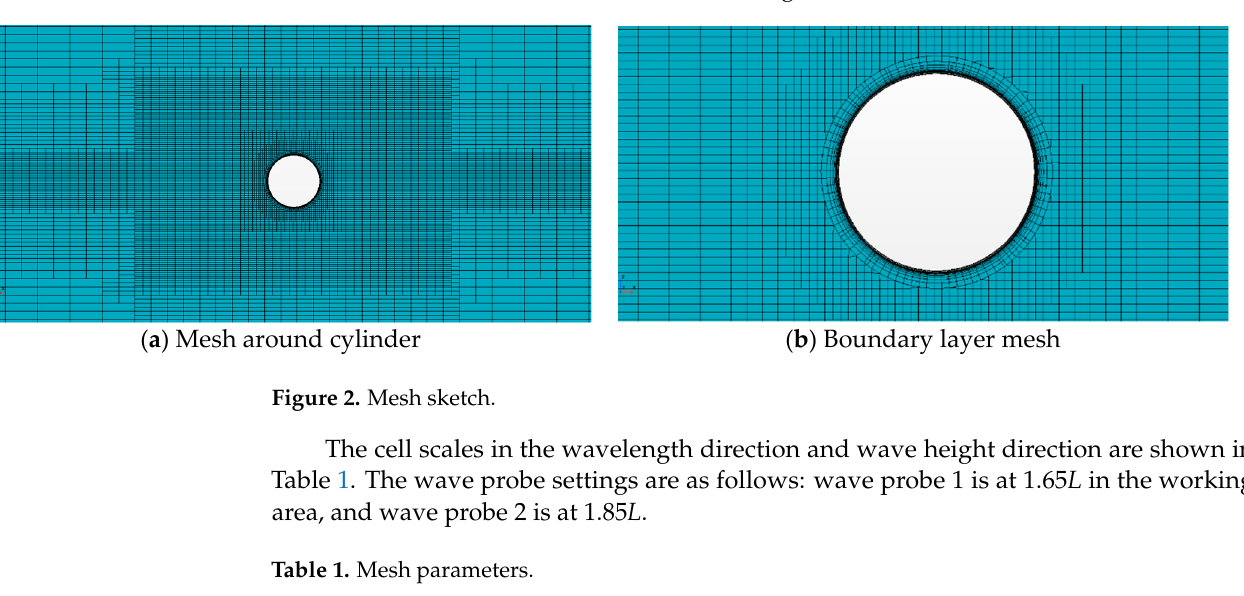
Table 1. Mesh parameters.